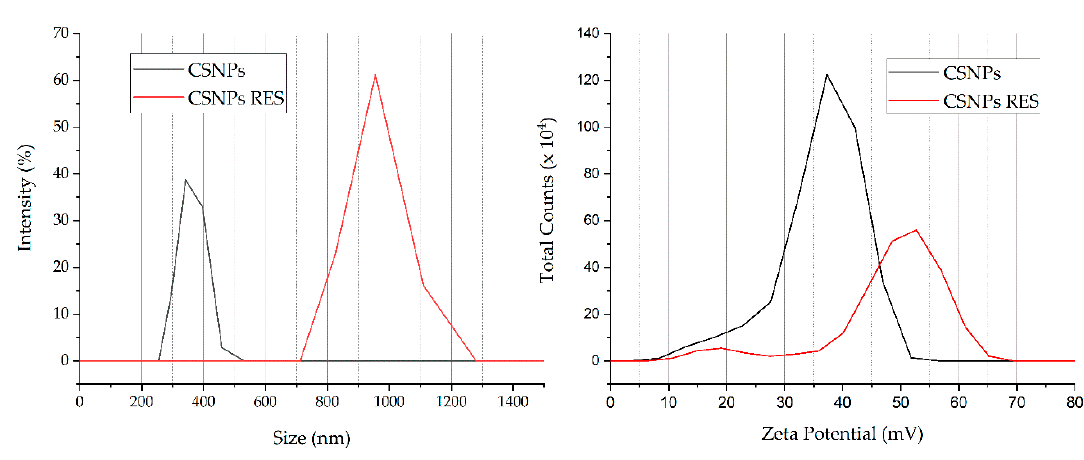
Figure 1. Particle size, PDI, and zeta potential of CSNPs and CSNPs RES.